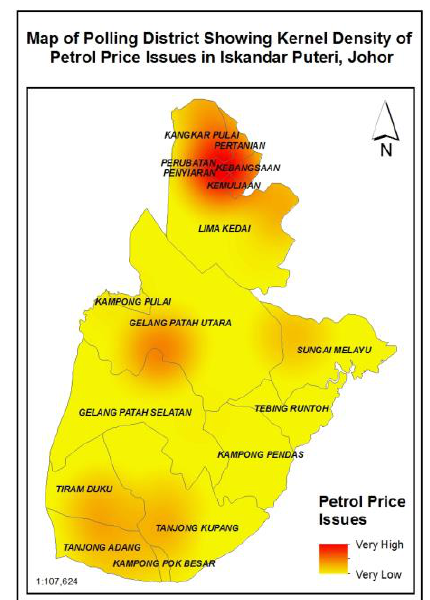
Figure 15. Result of the hot spot maps using KDA for petrol price